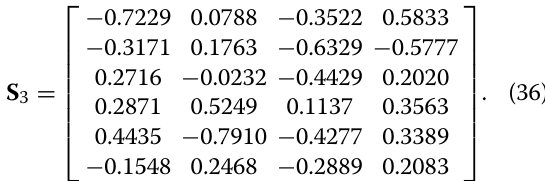
illustrated with numerical examples obtained from simu- lations which illustrate convergence and tracking proper- ties of the algorithm for different scenarios This change in system configuration triggers the adaptation stage of the algorithm, which yields beamforming matrix S 3 .